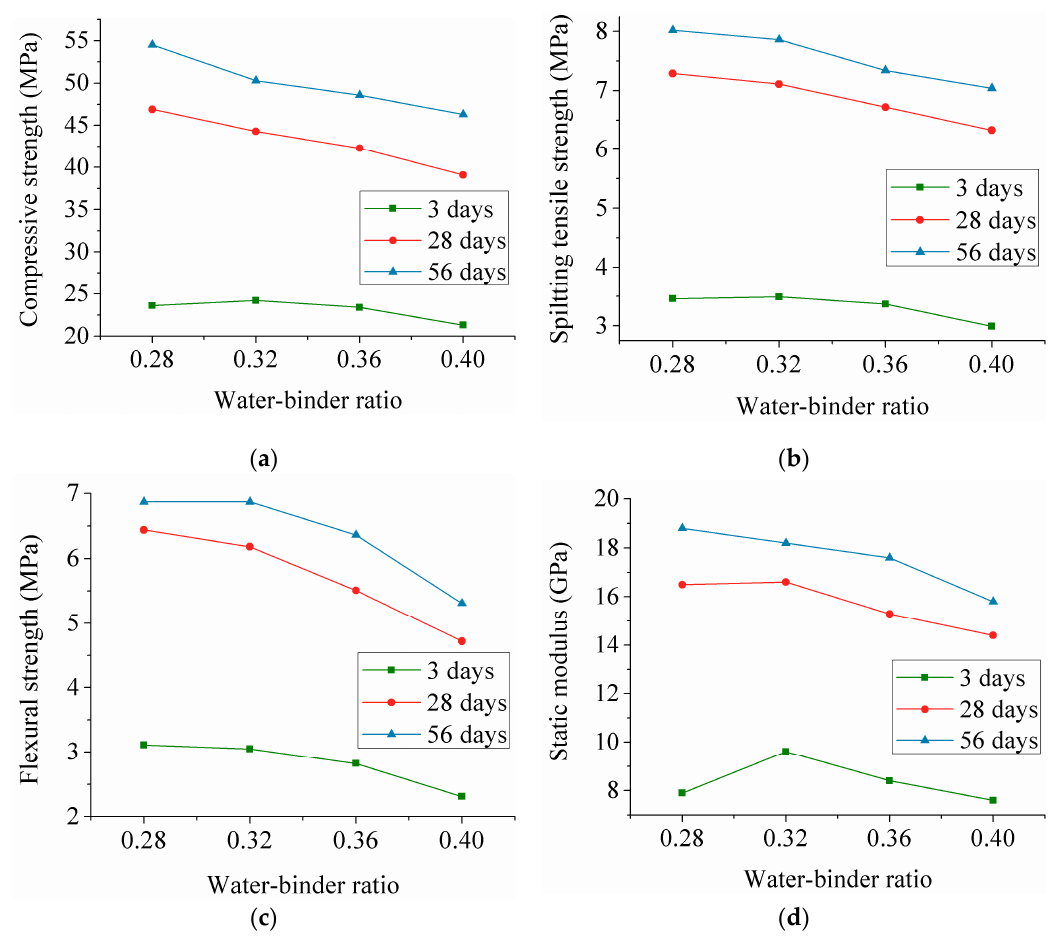
Figure 2. Mechanical properties of basalt fiber reinforced engineered cementitious composite (BF-ECC) for di ff erent W / B. ( a ) E ff ect of the W / B on the compressive strength; ( b ) E ff ect of the W / B on the splitting tensile strength; ( c ) E ff ect of the W / B on the flexural strength; ( d ) E ff ect of the W / B on the static